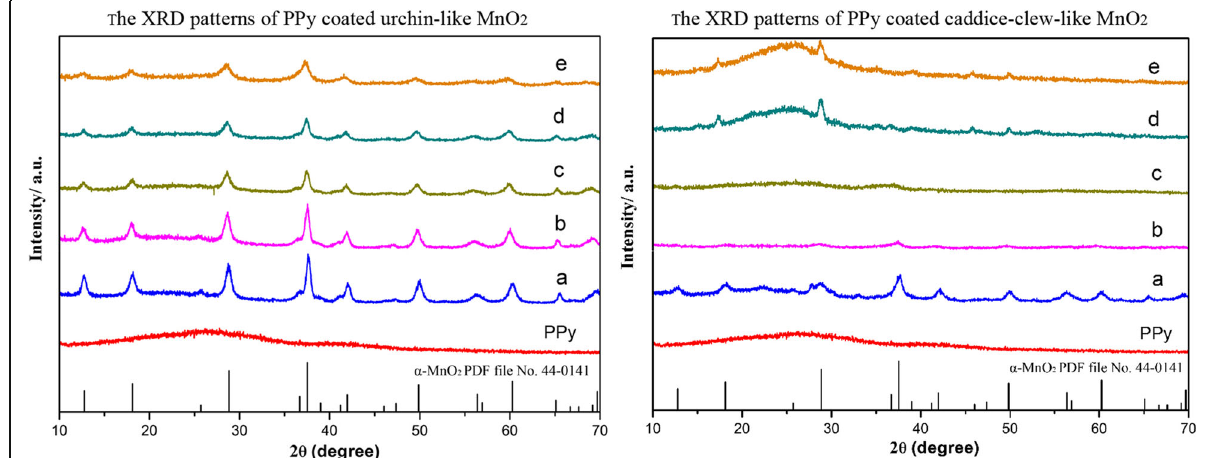
Fig. 5 The XRD patterns of PPy-coated MnO 2 samples. The left is ( a ) urchin-like MnO 2 sample and ( b ) 10 μ L, ( c ) 20 μ L, ( d ) 30 μ L, and ( e ) 50 μ L PPy-coated. The right is ( a ) caddice-clew-like MnO 2 sample and ( b ) 30 μ L, (c) 50 μ L, ( d ) 75 μ L( e ), and 100 μ L PPy-coated